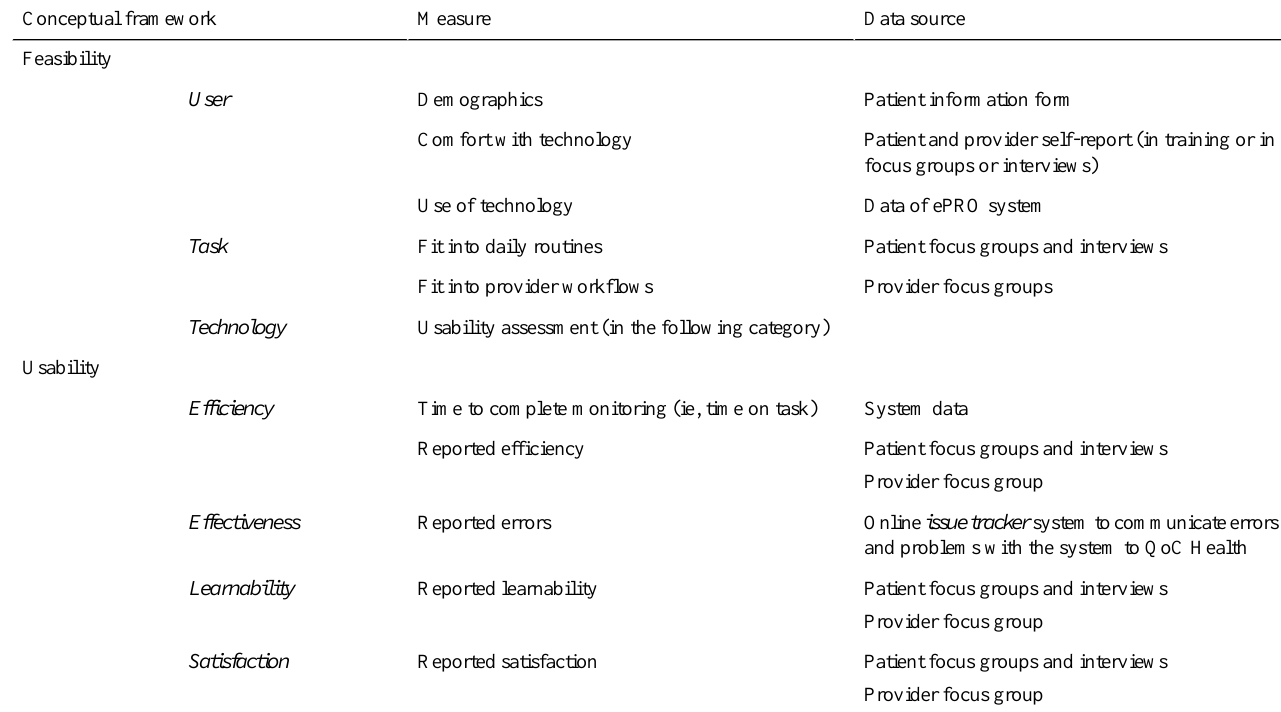
Table 1. Feasibility and usability measures.